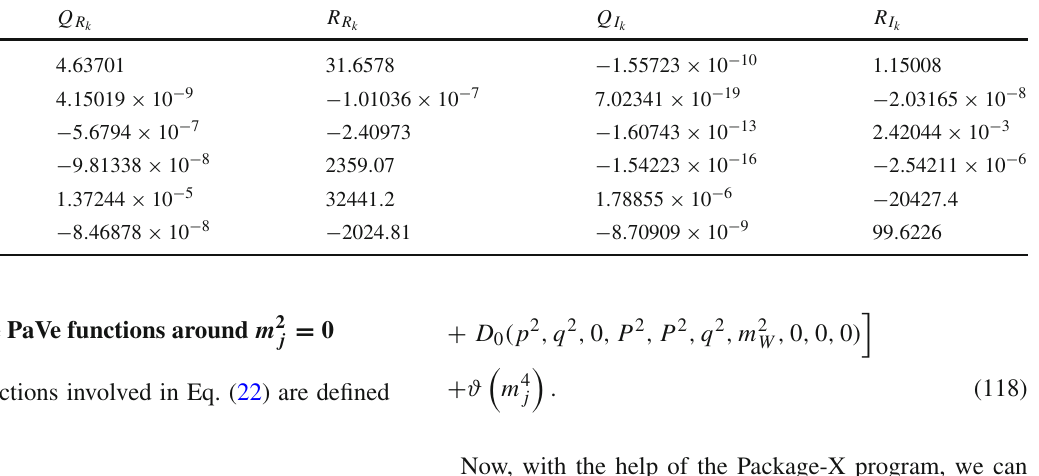
Table 8 Values for the Q R